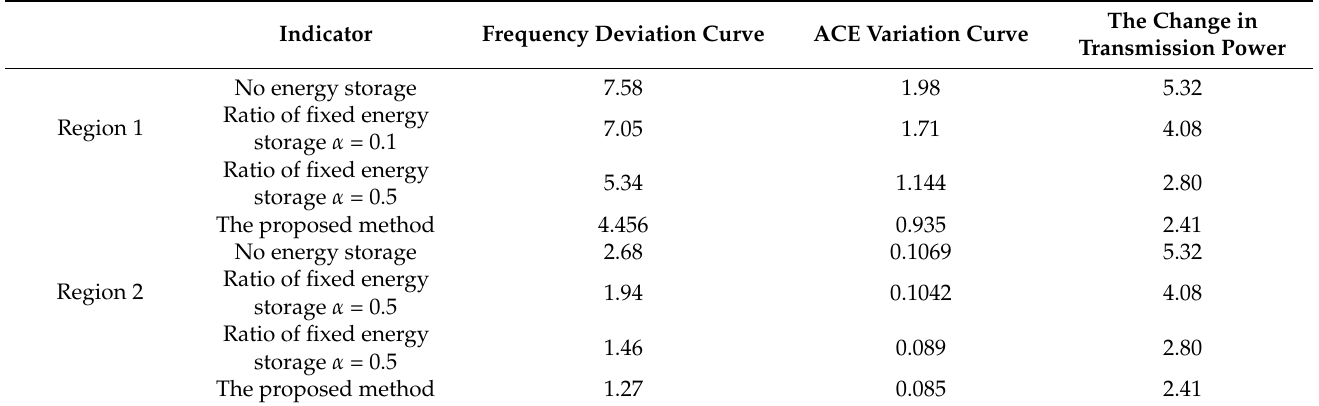
Table 2. Related indicators to secondary frequency